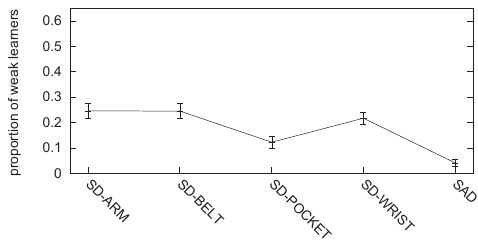
Figure 9: F-score corresponding to the number of iterations during inference process for BoostCRF.